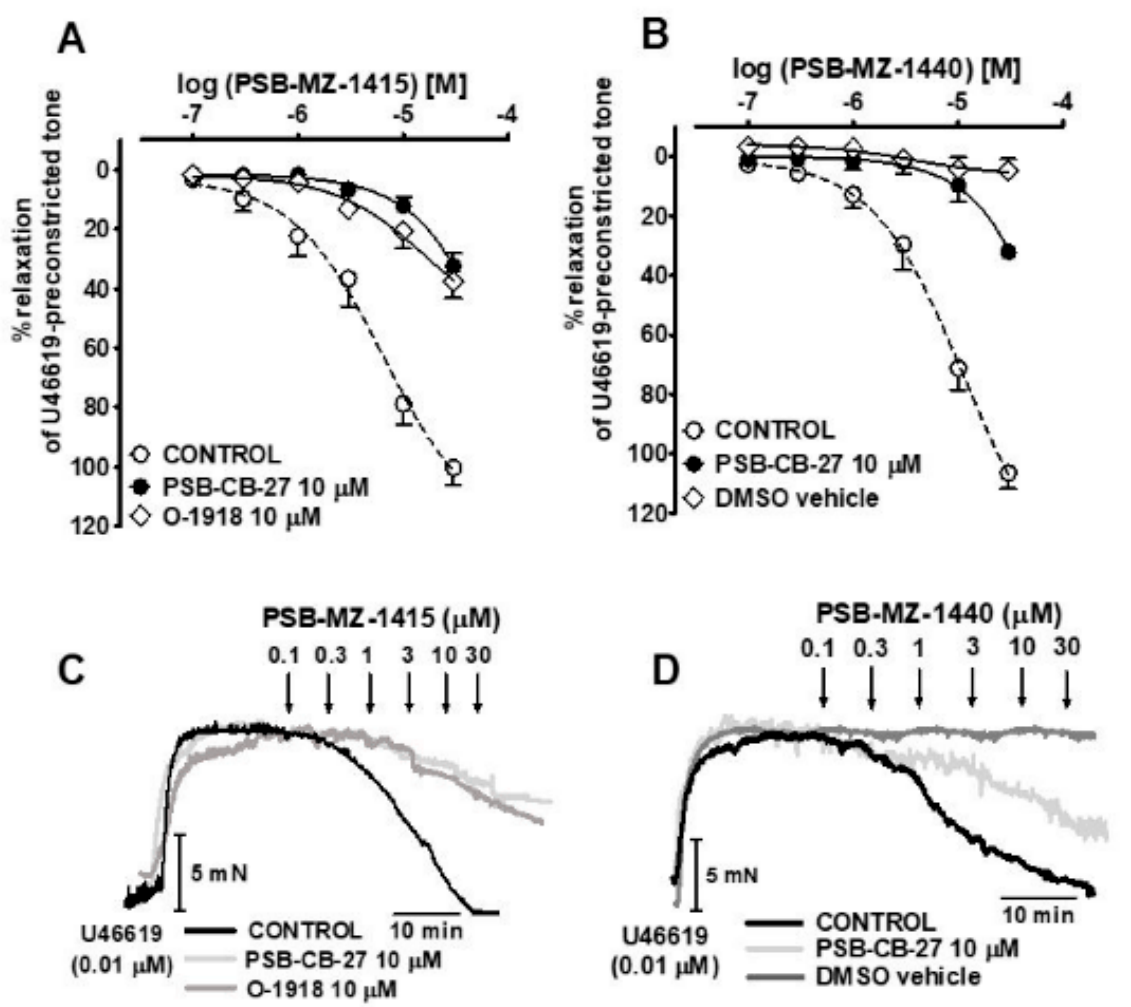
Figure 2. Influence of PSBCB–27 ( A – D ) and O–1918 ( A , C ) on the vasorelaxation induced by PSB– MZ–1415 ( A , C ) and PSB–MZ–1440 ( B , D ) in endothelium-intact isolated human pulmonary arteries. Concentration-response curves (mean ± SEM of 5–7 tissue samples) and representative original traces of the PSB–MZ–1415–( A , C ) or PSB–MZ–1440–( B , D ) induced relaxation (also in the presence of PSB–CB–27 or O–1918) are shown in the upper and lower panels, respectively. In ( A , B ), the results are expressed as the percentage relaxation of the isometric contraction induced by U46619. See Tables 1 and 2 for the statistical analysis and for potencies. CONTROL refers to the effects of the agonists in the absence of the particular antagonist. The effects of increasing concentrations of DMSO (max. < 1%), given repeatedly, are shown as well ( B , D ). Arrows show the moment of application of a particular concentration of PSB–MZ–1415 or PSB–MZ–1440. Table 2. Apparent pA 2 values of PSB-CB-27 and O-1918 for their interaction with NAGly, Abn-CBD, PSB-MZ-1415, and